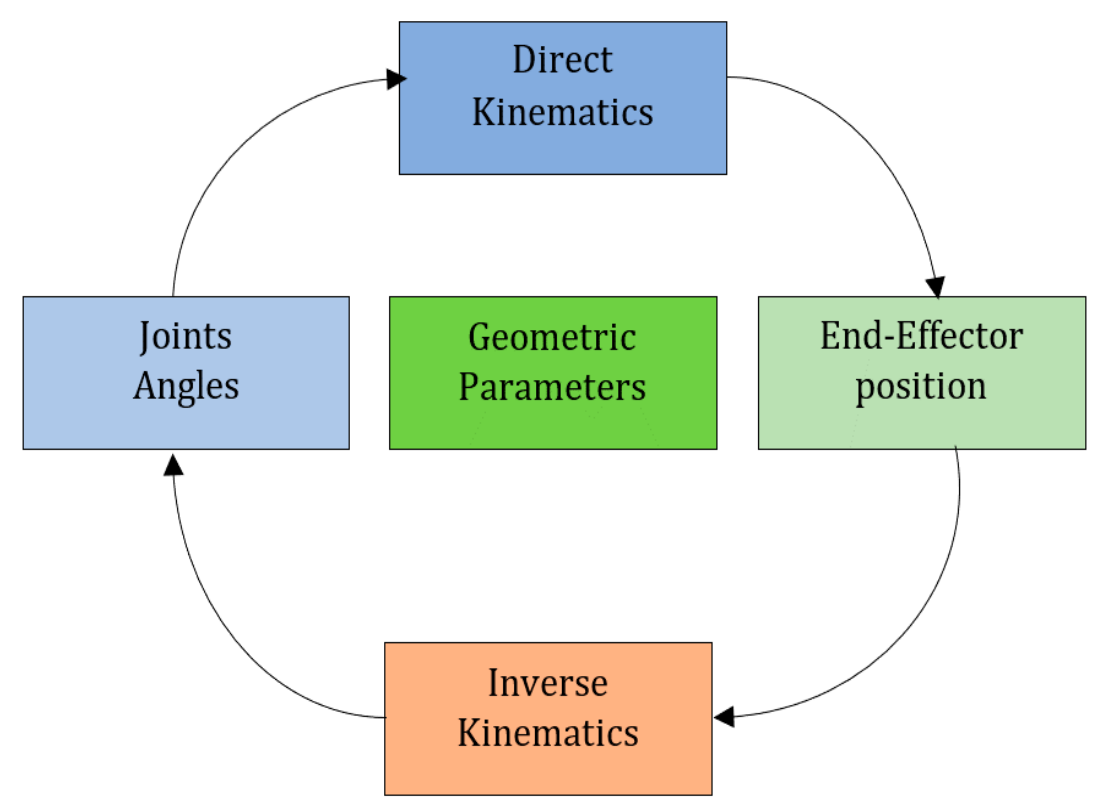
Figure 6. Block diagram of kinematics models.